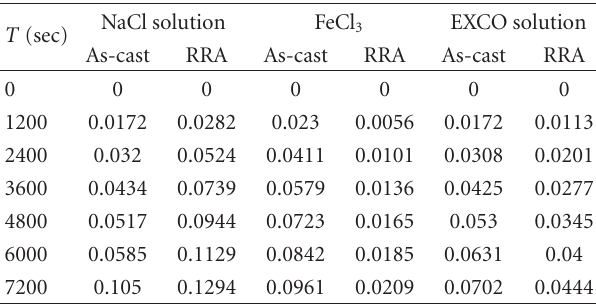
Table 9: Electrochemical corrosion rate For the 0.42% Mg speci- men.